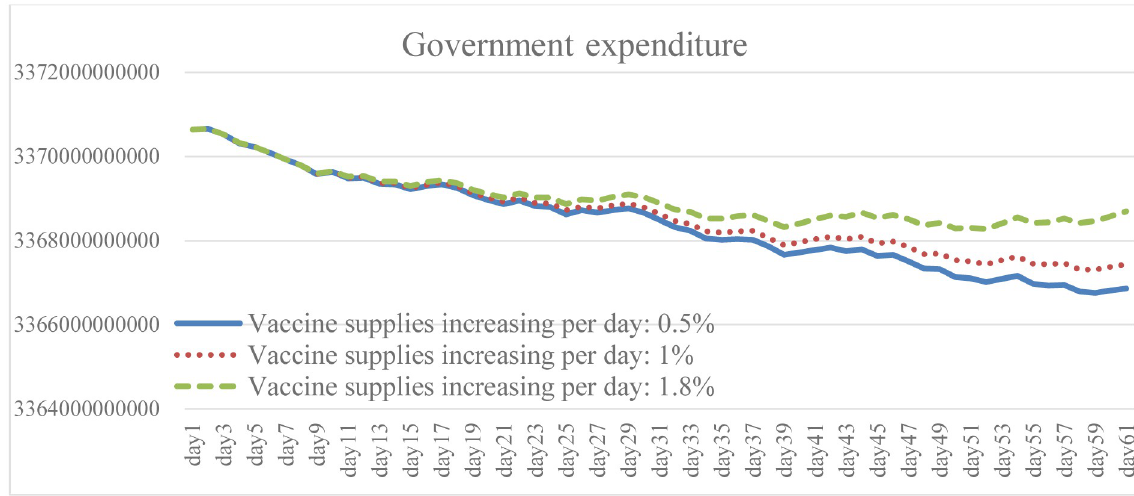
Fig 13. Government expenditure under different vaccine